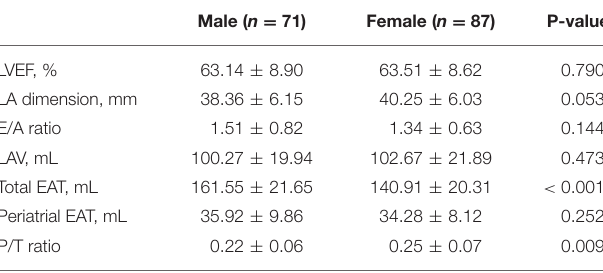
TABLE 1 | Baseline characteristics of the study populations. TABLE 2 | Imaging variables of the total population and stratified according to